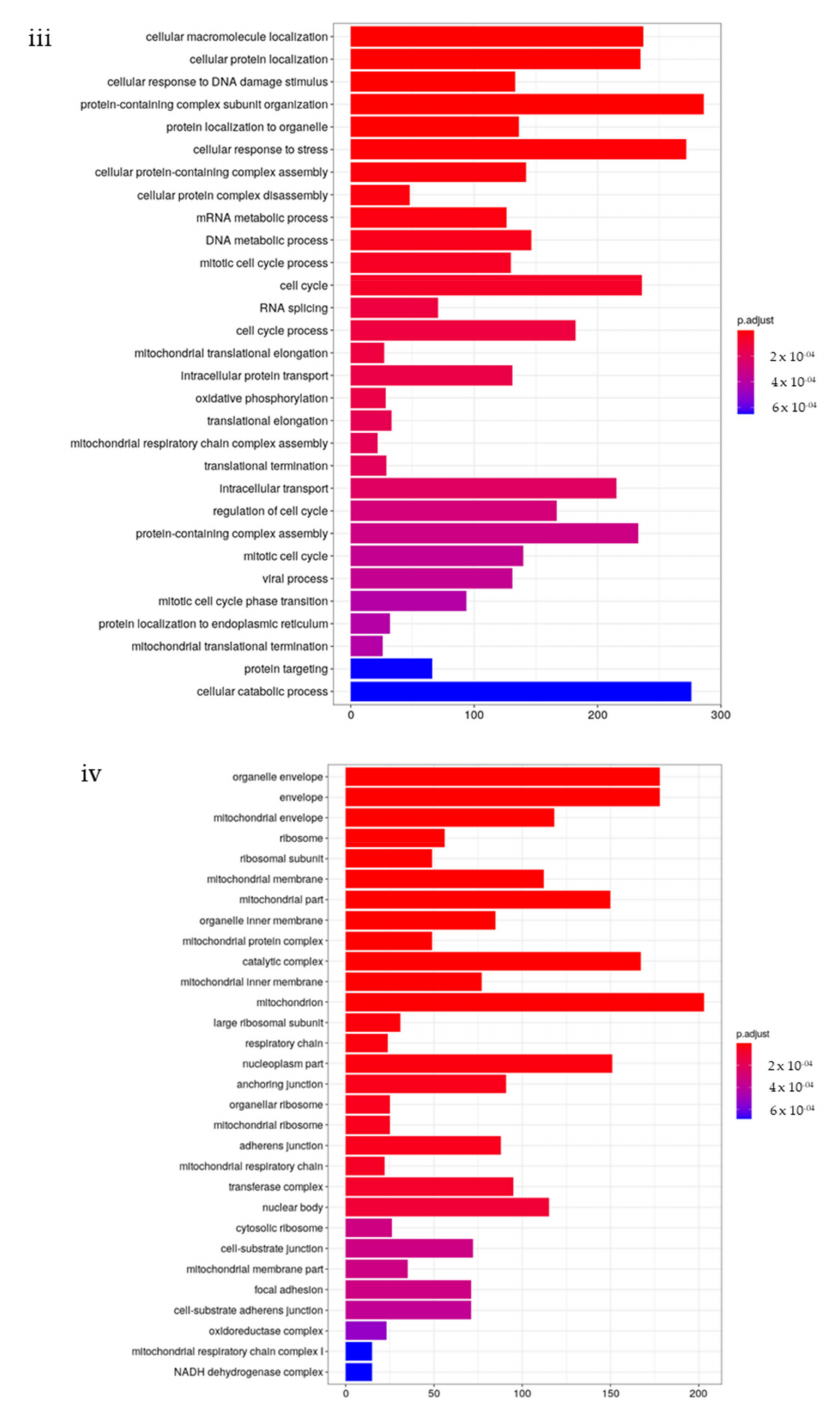
Figure 1. Gene expression profiling of ESRP1-modulated CRC cells. ( A ). ( i ) Heatmap of ESRP1-overexpressing and control CO-LO320DM cells. Cells are shown in columns and genes in rows (genes are reported as Gene Name and Illumina Array Address ID). Gene ontology keywords belonging to ( ii ) biological process domain and ( iii ) cellular component domain are reported on the y-axis, the number of differentially expressed genes involved in the corresponding GO term enrichment is defined on the x-axis, whereas the different colors highlight the different magnitude of the p -values (as in the legend). ( B ). ( i ) Heatmap of ESRP1-silenced and control HCA24 cells. Only gene showing a |log2FC| > 1.5 are considered in this graphical representation. Cells are shown in columns and genes in rows (genes are reported as Gene Name and Illumina Array Address ID). HCA24 enriched Gene